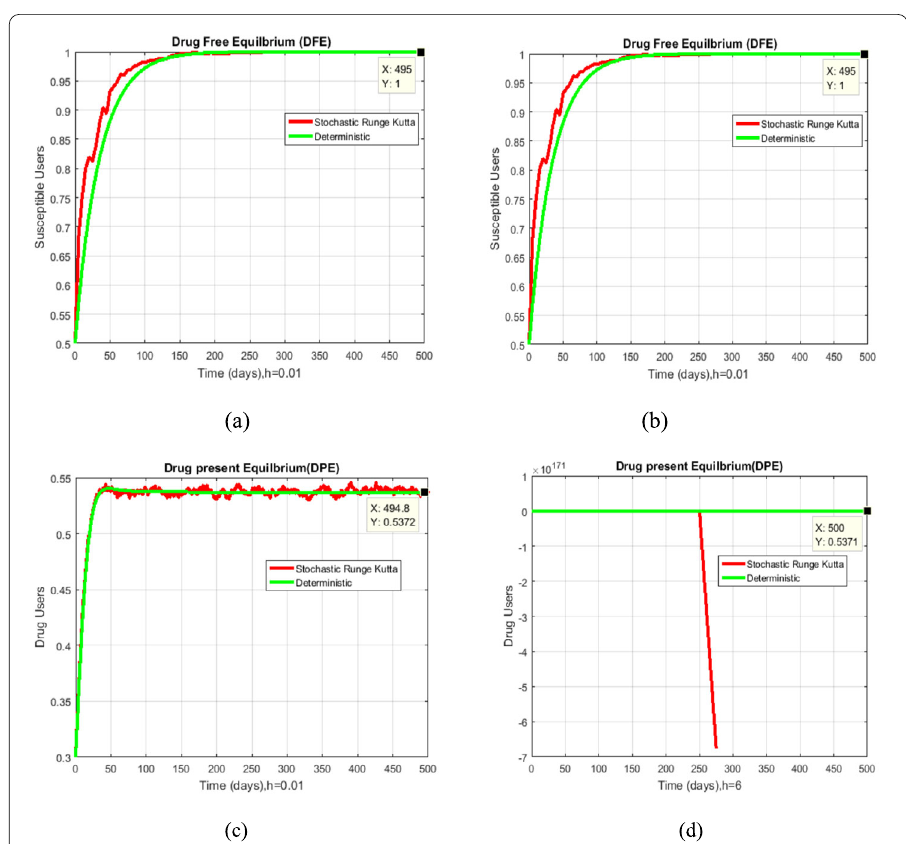
Figure 4 ( a ) In susceptible users’ fraction stochastic Runge–Kutta method converges to drug-free equilibrium, while deterministic solution is the mean of stochastic Runge–Kutta method solution for h = 0.01. ( b ) In susceptible users’ fraction stochastic Runge–Kutta method solution is unbound for drug-free equilibrium for h = 0.01. ( c ) In drug users’ fraction stochastic Runge–Kutta method converges to drug-present equilibrium, while deterministic solution is the mean of stochastic Runge–Kutta method solution for h = 0.01. ( d ) In drug users fraction stochastic Runge–Kutta method shows failure of dynamical properties for drug-present equilibrium for h =